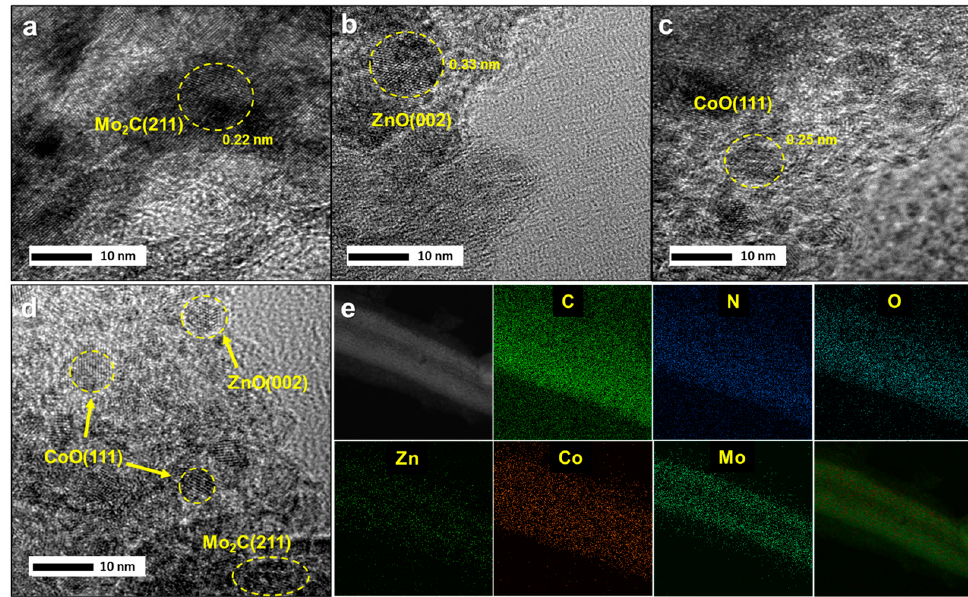
Figure 3. ( a – d ) HR-TEM images of Mo 2 C@BMZIF-700 °C (4 h) showing Mo 2 C, ZnO, and CoO phases and ( e ) corresponding elemental EDS maps of Mo 2 C@BMZIF-700 °C (4